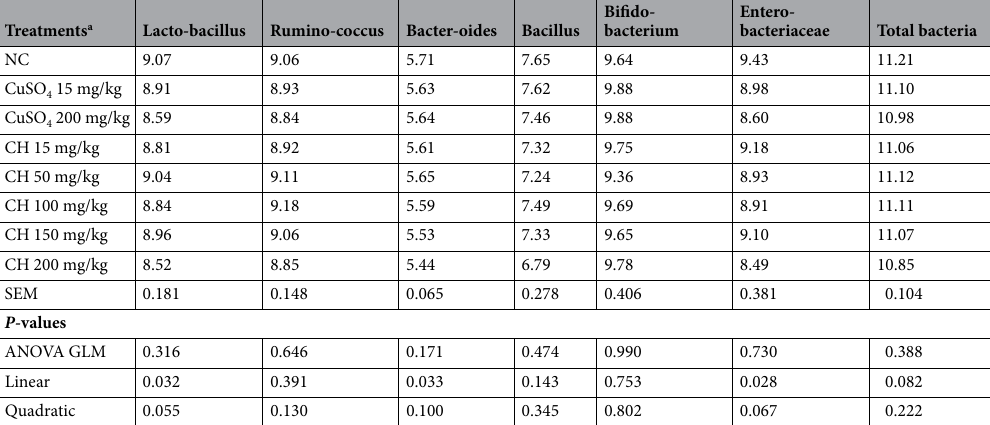
Table 8. Bacterial composition (Log 10 copy numbers g −1 ) in ceca content of broiler chickens at day 14. Mean values are based on 3 birds per replicate and 6 replicates per treatment. a NC Negative control, no added Cu, CH Copper hydroxychloride (Intellibond Cu).